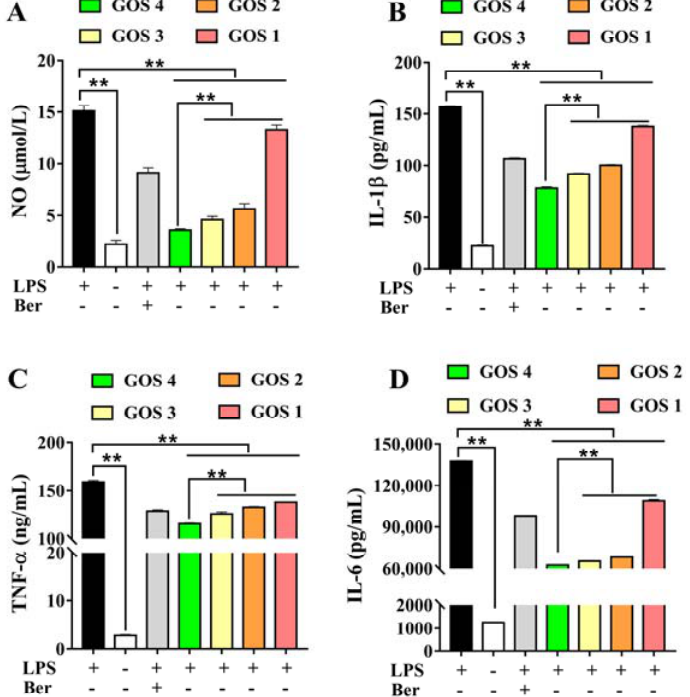
Figure 3. Effects of GOS1 ‐ 4 on levels of inflammatory mediator in RAW264.7 cells induced by LPS: ( A ) NO, ( B ) IL ‐ 1 β , ( C ) TNF ‐α , and ( D ) IL ‐ 6. One ‐ way ANOVA combined with Duncan’s test, ** p < 0.01, the difference was statistically significant.